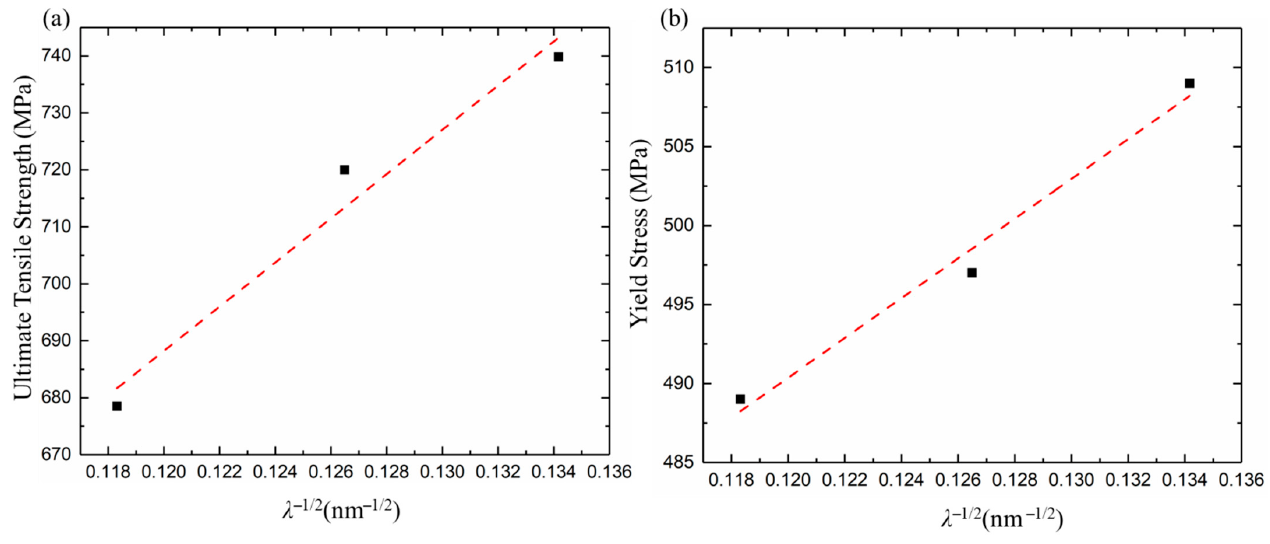
Figure 11. ( a ) UTS and ( b ) YS versus λ − 1/2 scattering plots using Equation